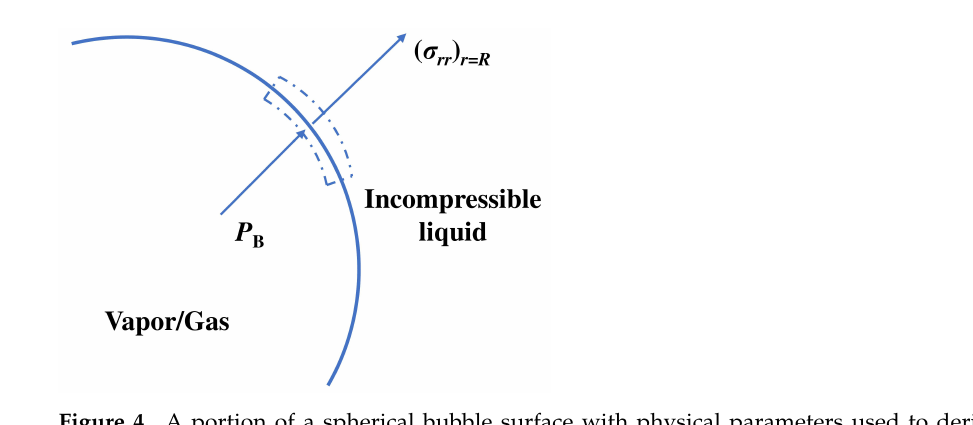
Figure 4. A portion of a spherical bubble surface with physical parameters used to derive the RP